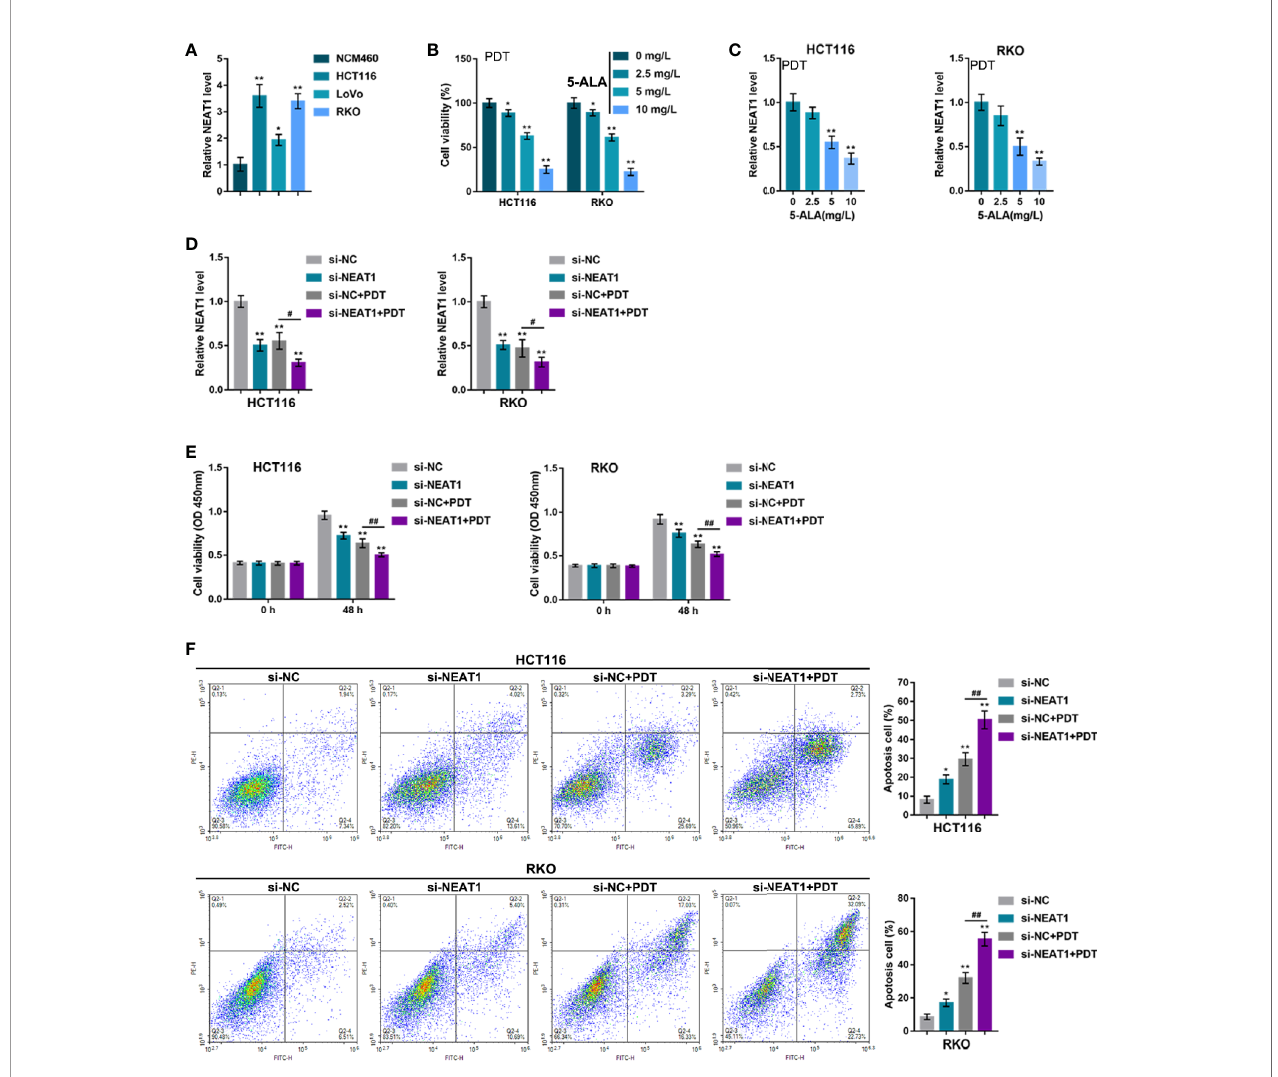
FIGURE 1 | Silencing lncRNA NEAT1 enhances the sensitivity of colorectal cancer (CRC) cells to PDT treatment. (A) The expression levels of NEAT1 was determined in a normal cell line, NCM460, and three CRC cell lines, HCT116, RKO, and LoVo, by qRT-PCR. Then, HCT116 and RKO cells were incubated with 0, 5, 10, or 20 mg/L 5-ALA, treated with PDT and examined for cell viability by CCK-8 assay (B) and NEAT1 expression levels by qRT-PCR (C) . Next, HCT116 and RKO cells were transfected with small interfering RNA targeting NEAT1 (si-NEAT1; si-NC as a negative control), subjected to or non-subjected to PDT treatment, and examined for the expression levels of NEAT1 by qRT-PCR (D) , cell viability by CCK-8 assay (E) , and cell apoptosis by Flow cytometry (F) . * P < 0.05, ** P < 0.01, compared with NCM460, 0 mg/L or si-NC group; # P < 0.05, ## P < 0.01, compared with si-NC+PDT